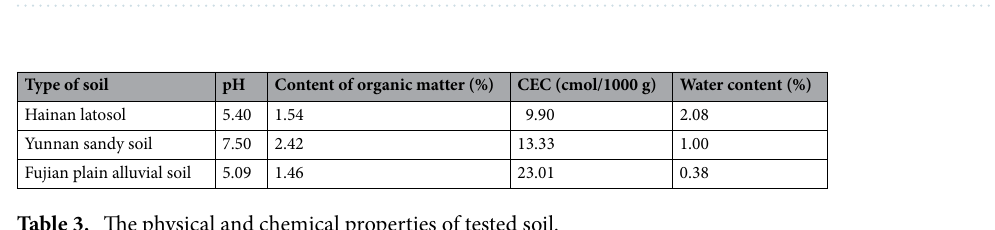
Table 2. The chemical dissipation kinetic parameters of fluopyram in different types of soil.